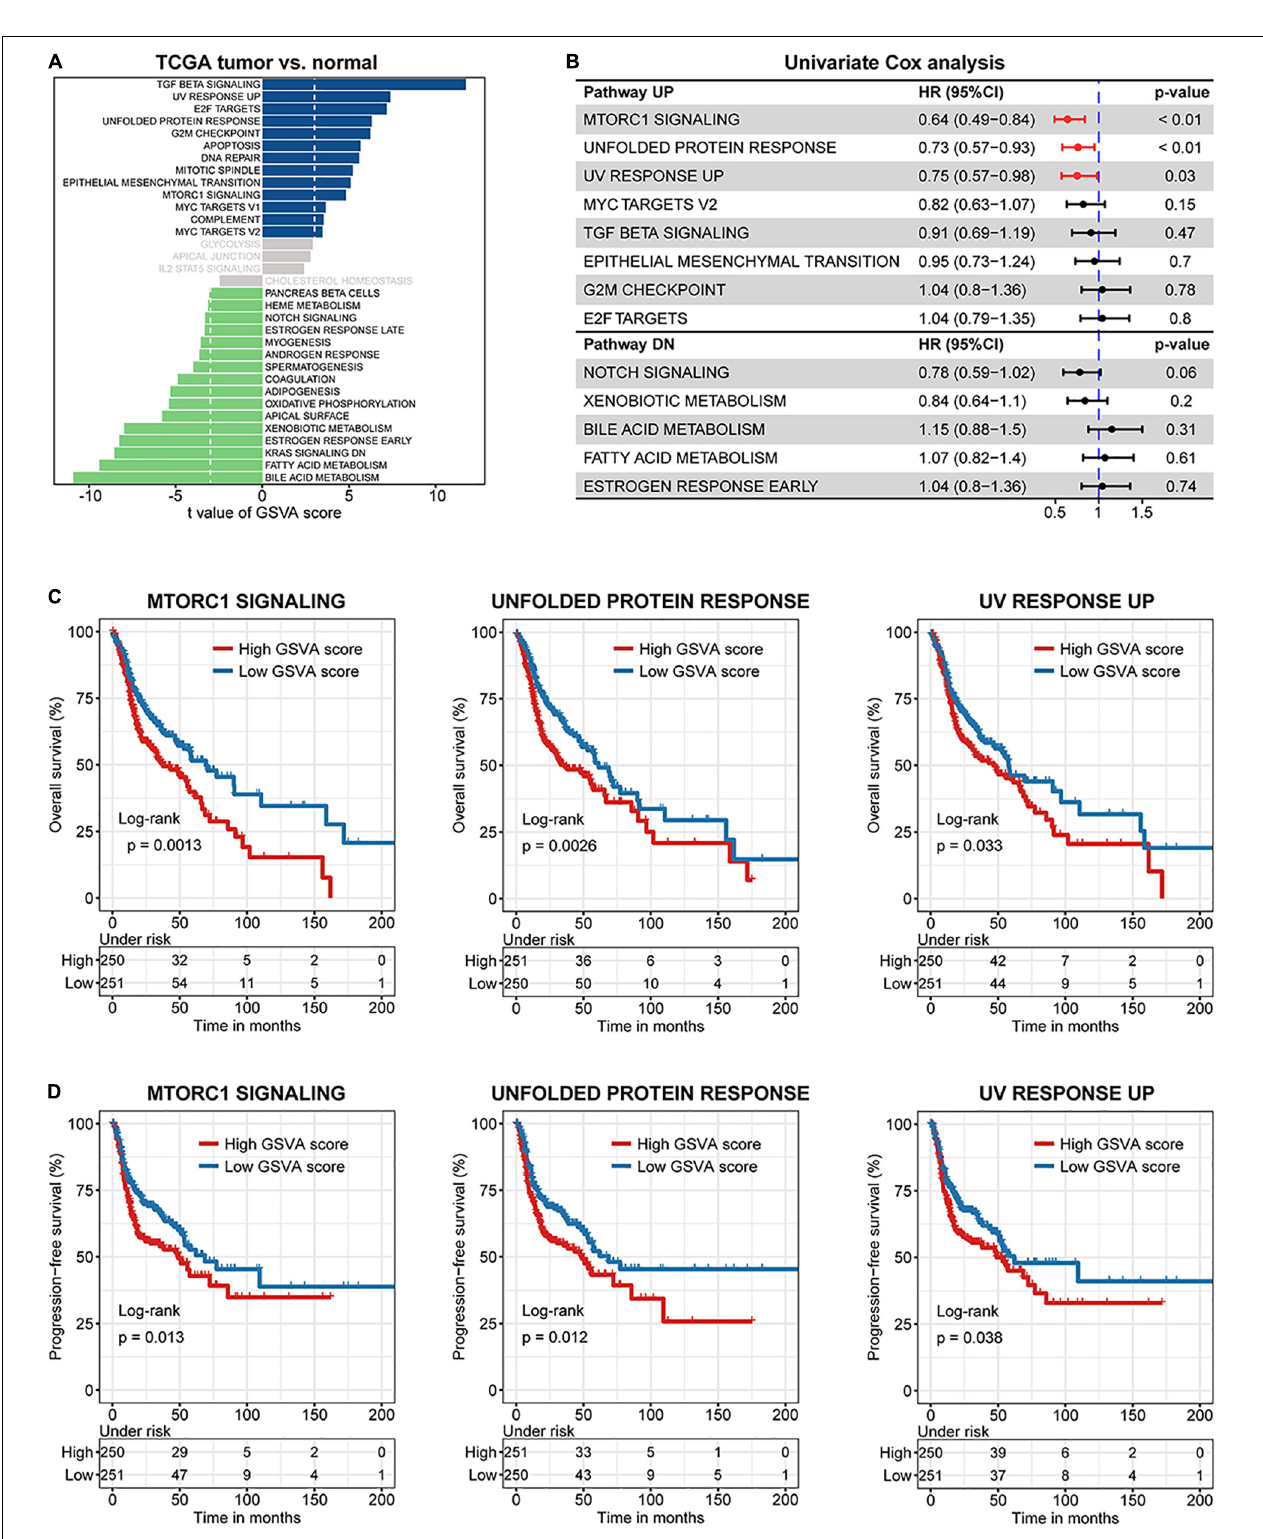
FIGURE 1 | The major prognostic pathways in head and neck squamous cell carcinoma (HNSCC) identified by gene set variation analysis (GSVA). (A) Differences in pathway activities scored per sample by GSVA between paired tumor and normal HNSCC in The Cancer Genome Atlas (TCGA) ( n = 44). Shown are t -values from a linear model, corrected for patient of origin. dn, down; UV, ultraviolet; v1, version 1; v2, version 2. (B) Univariate Cox regression analysis among various hallmarks of cancer. Kaplan–Meier curves of overall (C) and progression-free (D) survival for HNSCC patients in the two groups divided by GSVA pathway score.